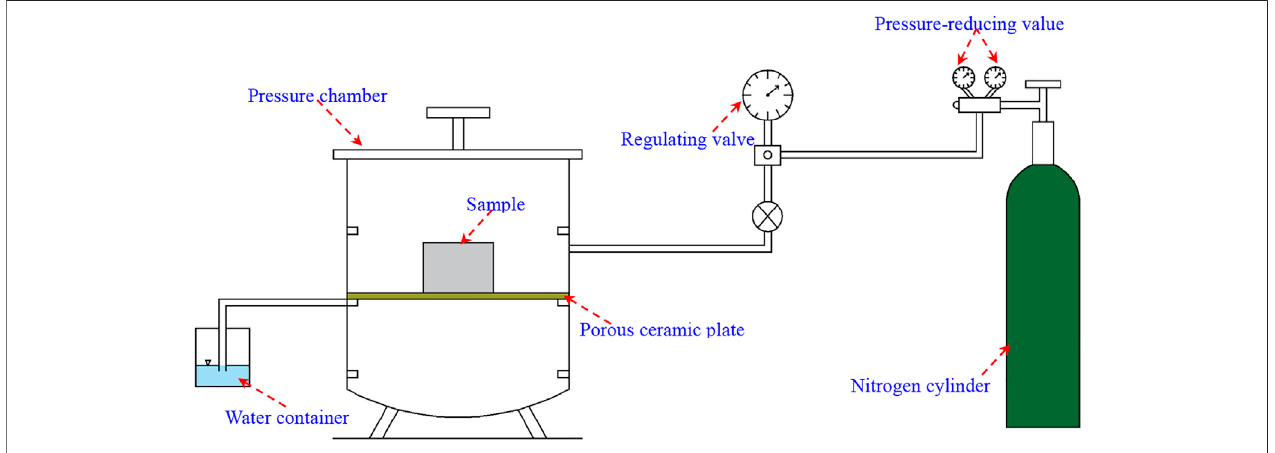
FIGURE 3 | Schematic diagram of the pressure plate